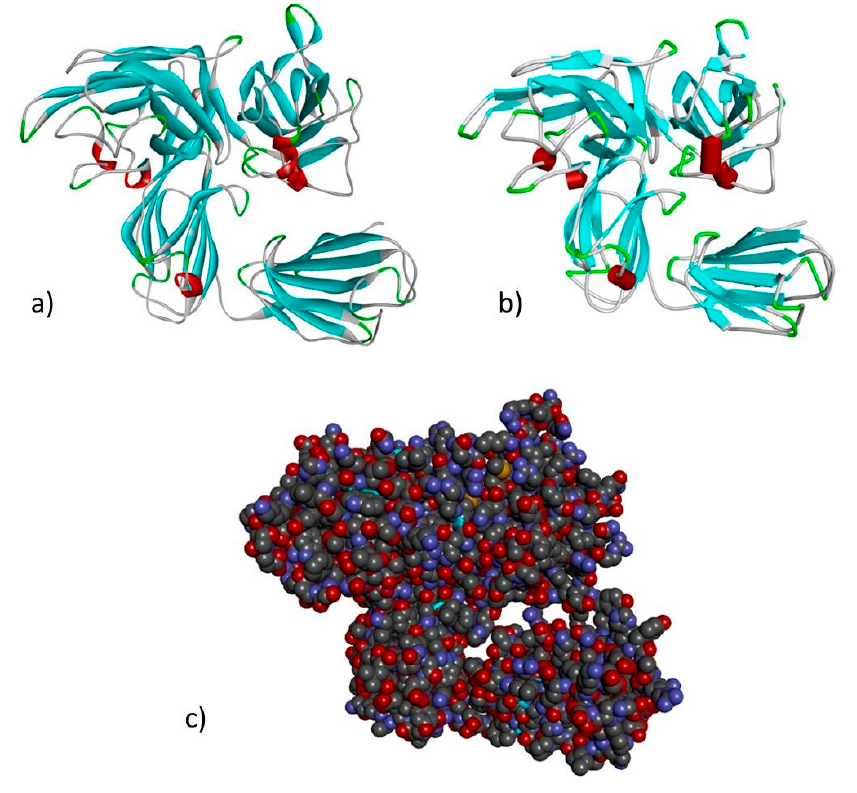
Figure 5. Modeled structure of the NRP2 gene in ( a ) ribbon ( b ) schematic and ( c ) CPK views. Cyan regions are β sheets, white represents loops and red represents α helices.